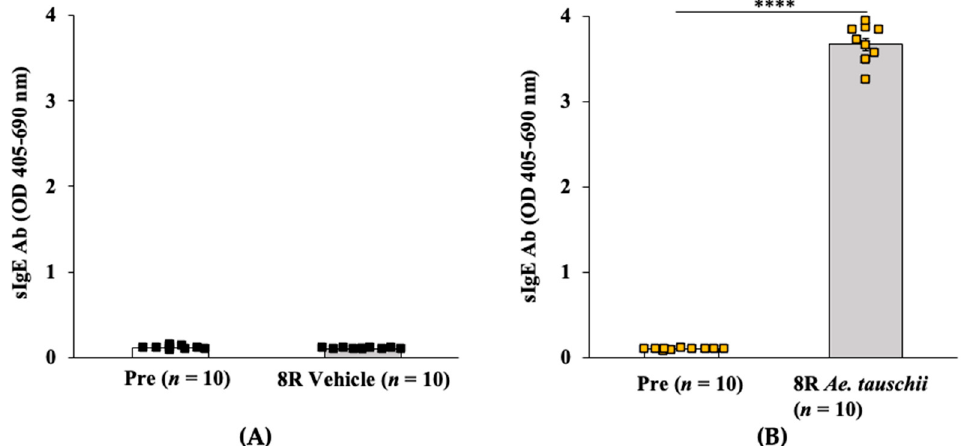
Figure 7. Transdermal exposure of Balb/c mice to SSPE from Aegilops tauschii elicited robust specific (s) IgE antibody responses. Mice were exposed to Ae. tauschii SSPE or saline as described in Methods. Plasma collected before the 1st exposure (Pre) and after the 8th exposure (8R) was used in the measurement of sIgE levels (OD 405–690 nm). ( A ) sIgE levels in control mice. ( B ) sIgE levels in sensitized mice. **** p < 0.001, student’s t -test. Ab: antibody, n : number of mice, SSPE: salt-soluble protein